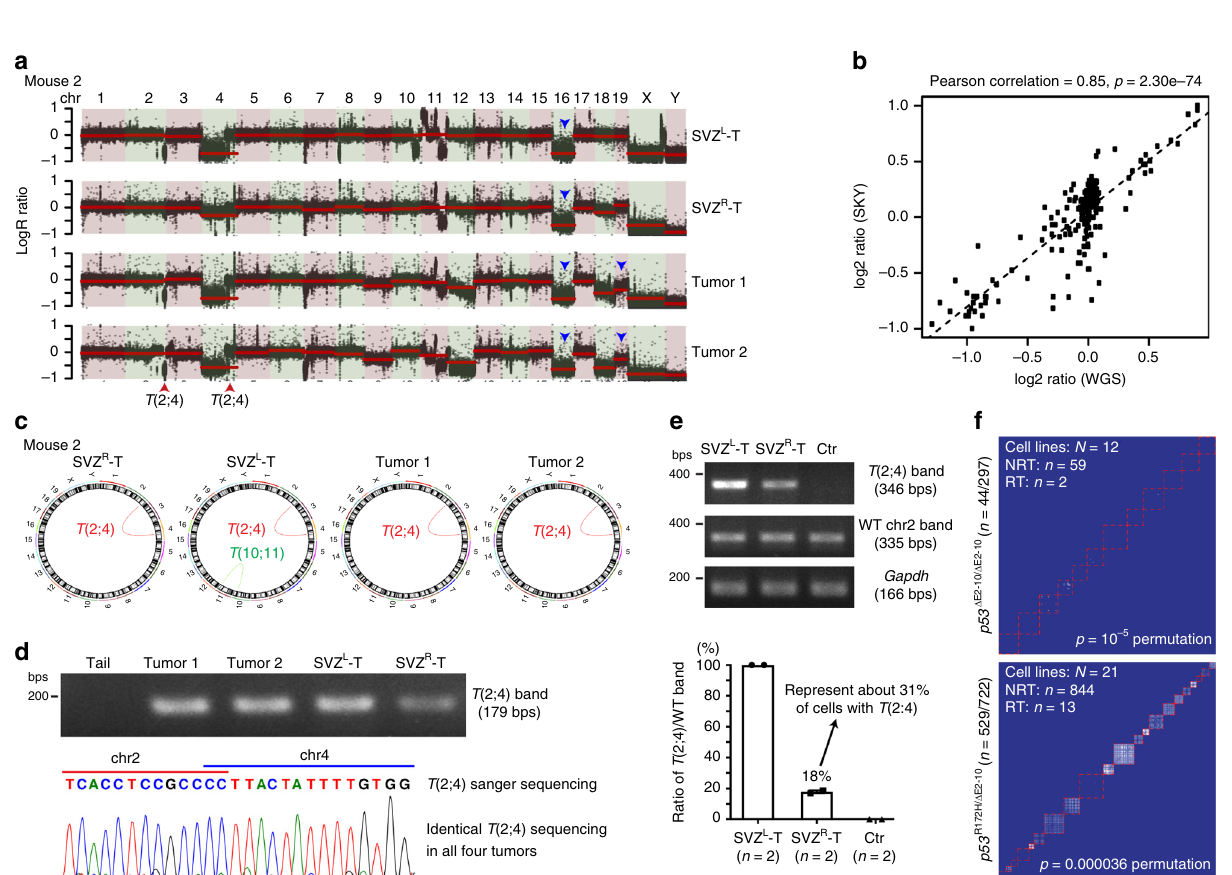
Fig. 4 WGS validates SKY-based cytogenetic markers used for phylogenetic trees. a The WGS-based copy number (CN) ratios of four tumor samples over tail (black points) from Mouse 2 were compared to the average of chromosome copy numbers obtained from SKY analysis (solid red segments). Arrowheads indicate the t (2;4) acquisition (red) and chromosome loss (blue). b Comparison of whole-chromosome CNV estimation (log2 ratio) between WGS and SKY using Pearson correlation coef fi cient (r). Dots represent each chromosome in each sample ( n = 13). Dotted line represents a linear regression line between WGS and SKY estimations. c WGS analysis of primary cells from four tumors in Mouse 2 shows the interchromosomal rearrangement t (2;4) (red line) and t (10;11) (green line). d , e Sanger sequencing of t (2;4) and wild-type chr2 in Mouse 2 ( d ), with malignant glioma from other animal as control. q-PCR analysis shows the relative ratio of t (2;4) to wild-type chr2 between SVZ L -T (100%) and SVZ R -T (40%), exhibiting an excellent agreement with the SKY data ( e ). Source data are provided as a Source data fi le. f Sample-wise NRT sharing matrix was built for p53 null CKO and p53 R172H CKO gliomas. Shared NRTs between metaphases are displayed using a heatmap. Blue indicates no shared NRTs and red indicates shared NRTs. Red dashed squares indicate metaphases from a single